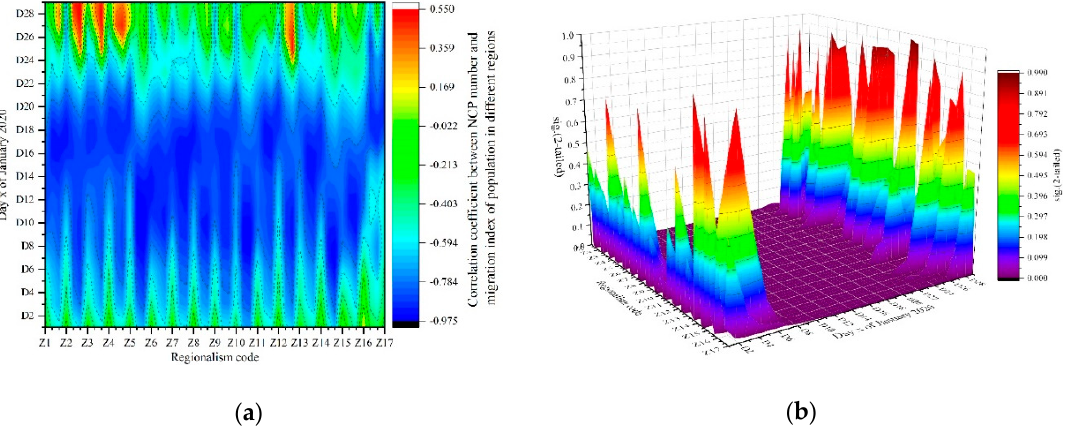
Figure 6. Time-serial correlation between immigration and COVID-19 confirmed cases: ( a ) the correlation result; ( b ) the corresponding significance. Notes: D2 refers to the second day of January, 2020 and the labels can be explained similarly; Z1-Z17 refer to the 17 prefecture-level cities in Table 2; The different colors in Figure 6a, b reveal the degree of correlation at different spatio-temporal points and the significance of each corresponding point.